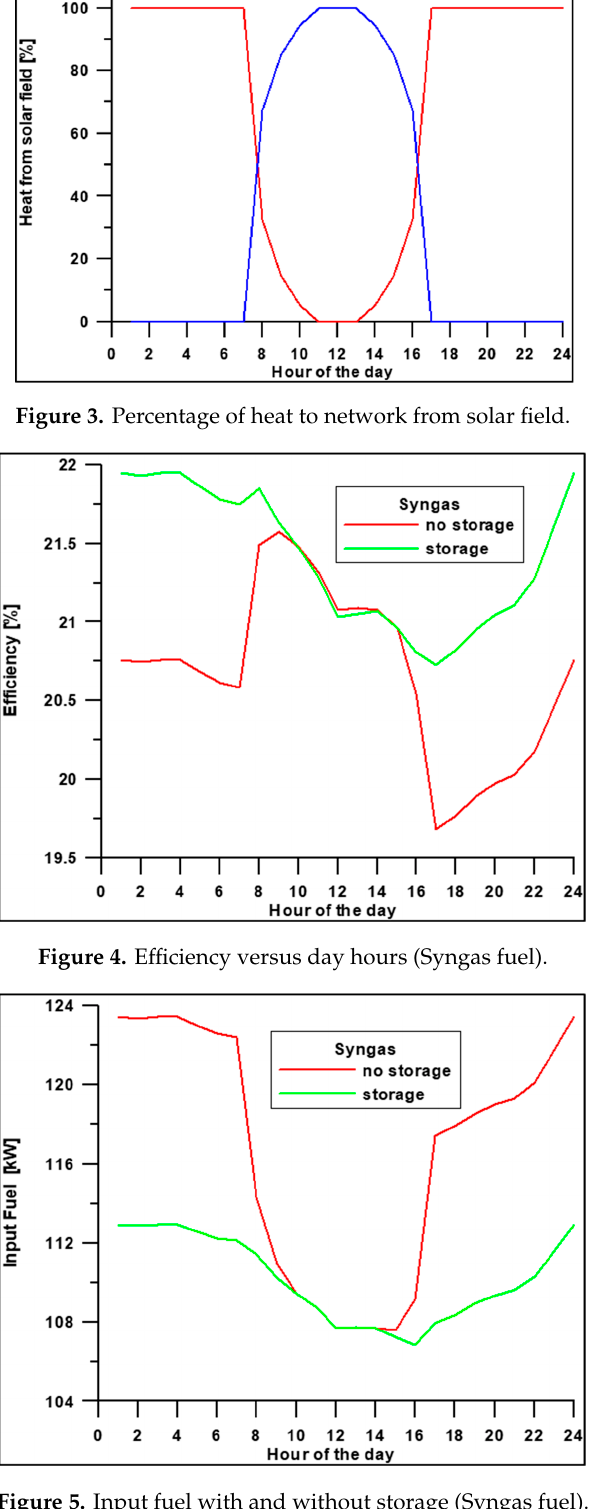
Figure 5. Input fuel with and without storage (Syngas fuel).